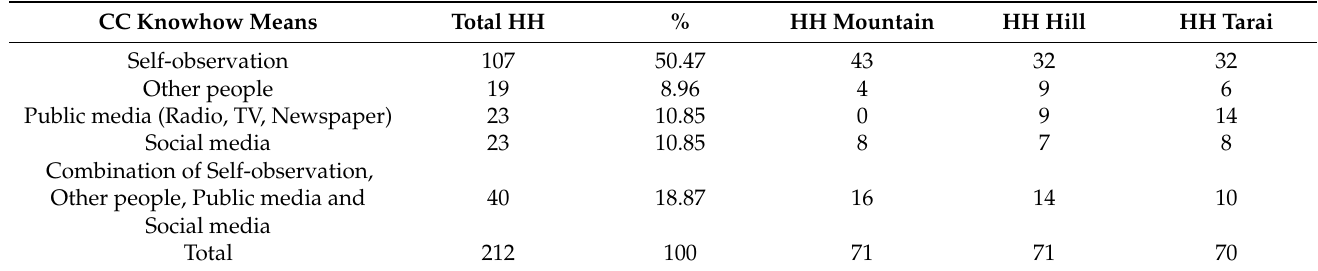
Table 4. Farmer’s sources of information on climate change.